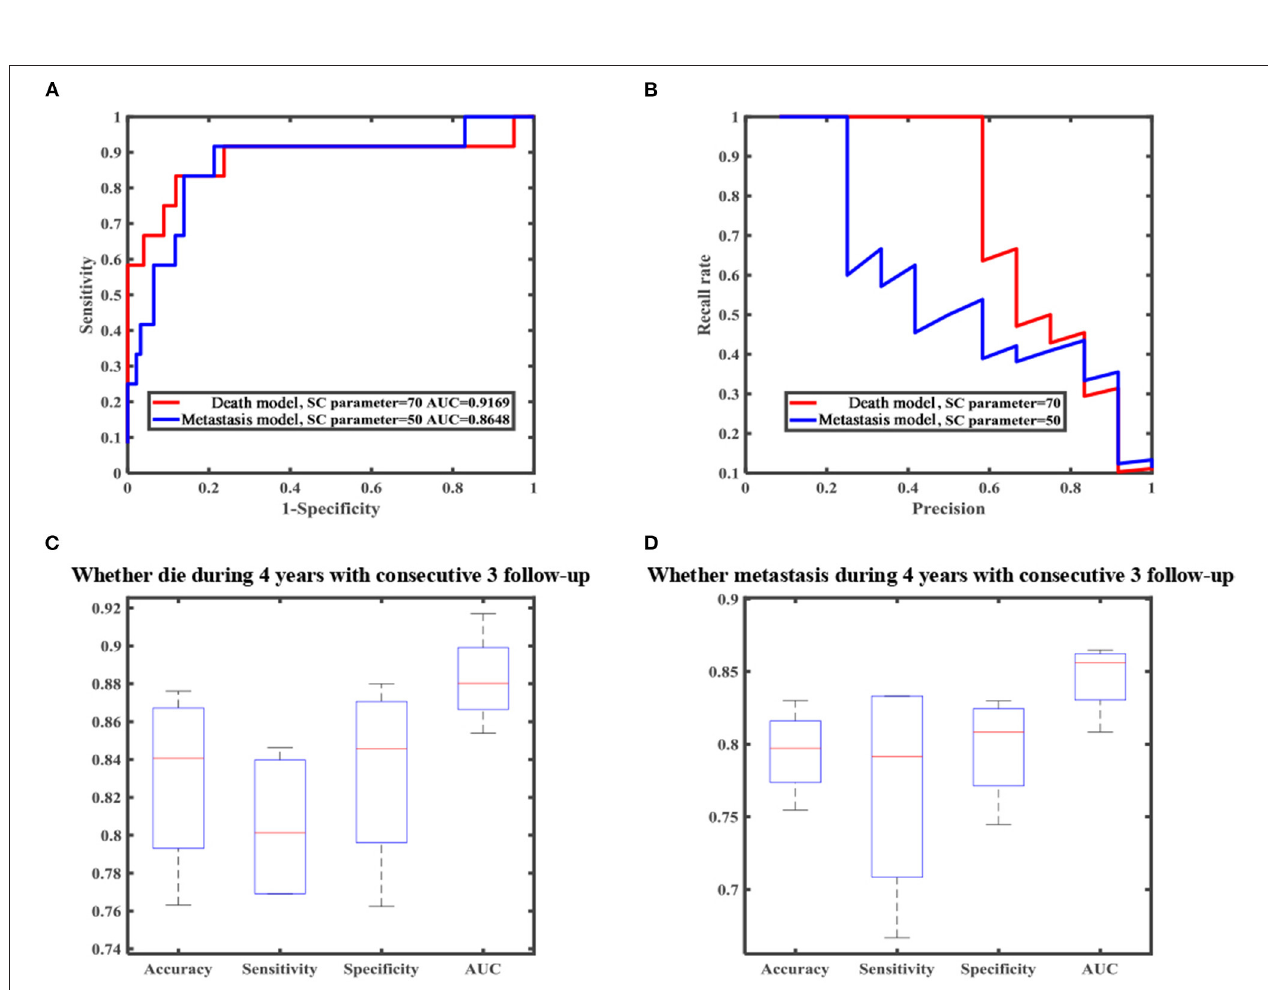
FIGURE 4 | Machine learning result of death and metastasis model. (A) Receiver operating characteristic (ROC) curve. (B) Precision-recall (PR) curve. (C) Boxplot of all metrics for predicting death. (D) Boxplot of all metrics for predicting metastasis.